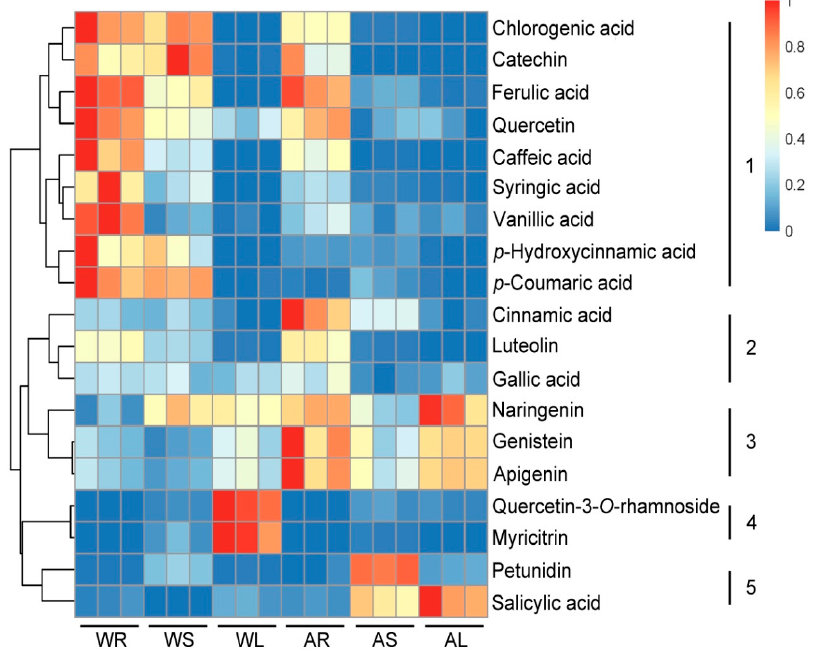
Figure 3. Heat map visualization of phenolics in different tissues of ASH and ASS. The color range from red to blue indicates relative abundance from high to low (color key scale right the heat map).